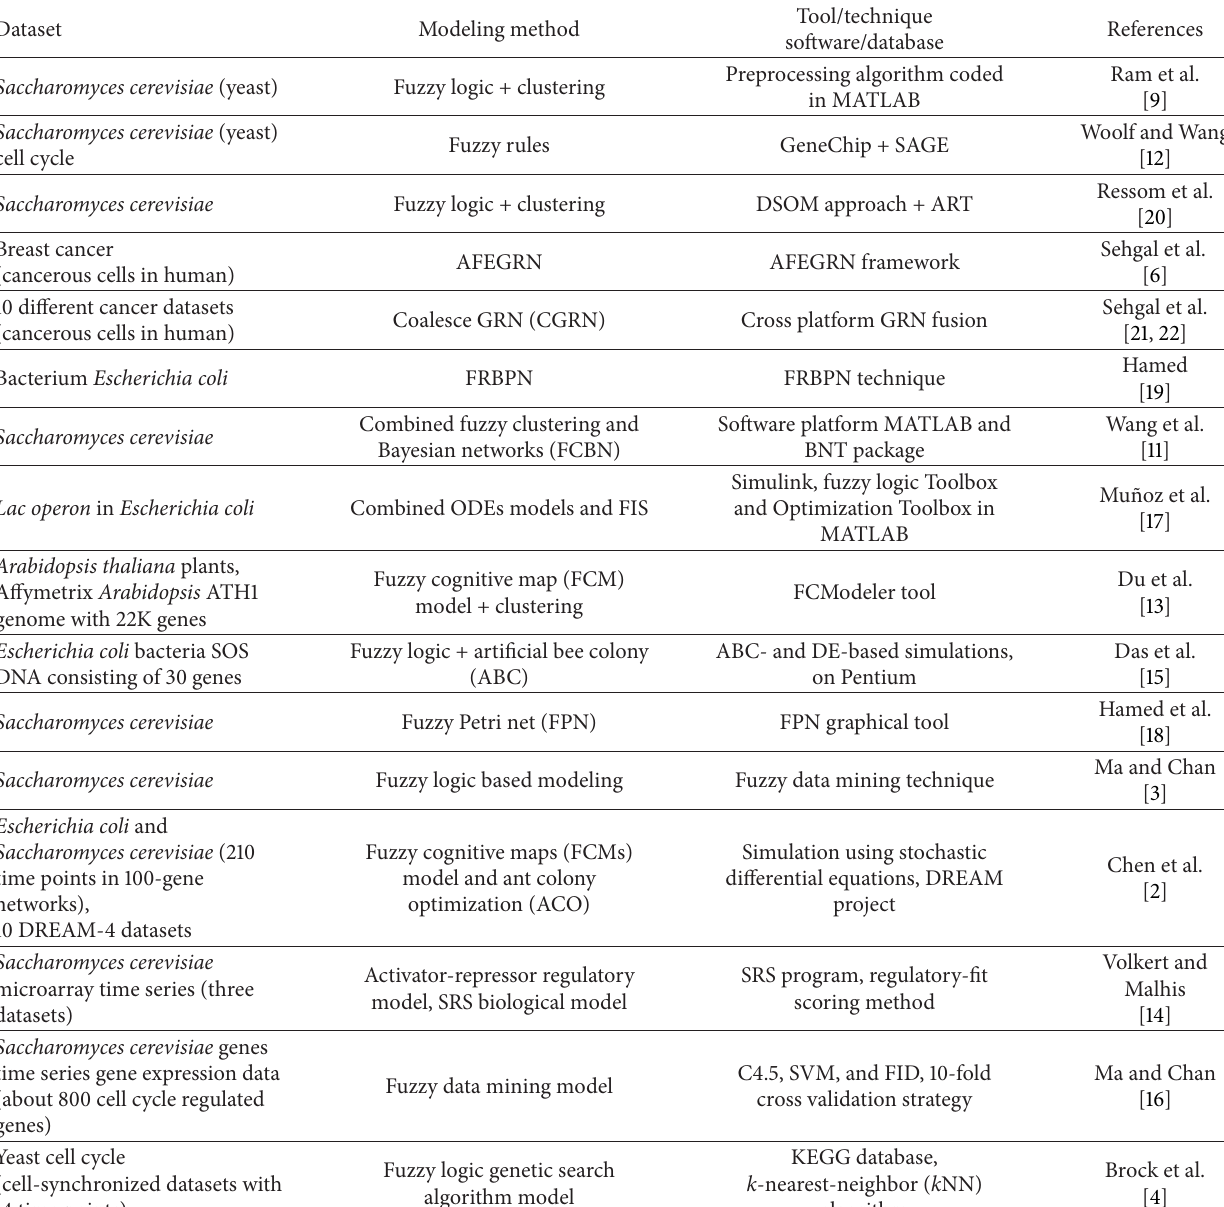
Table 4: Main fuzzy methods in GRN